Question: What does this figure show? Answer in one sentence.
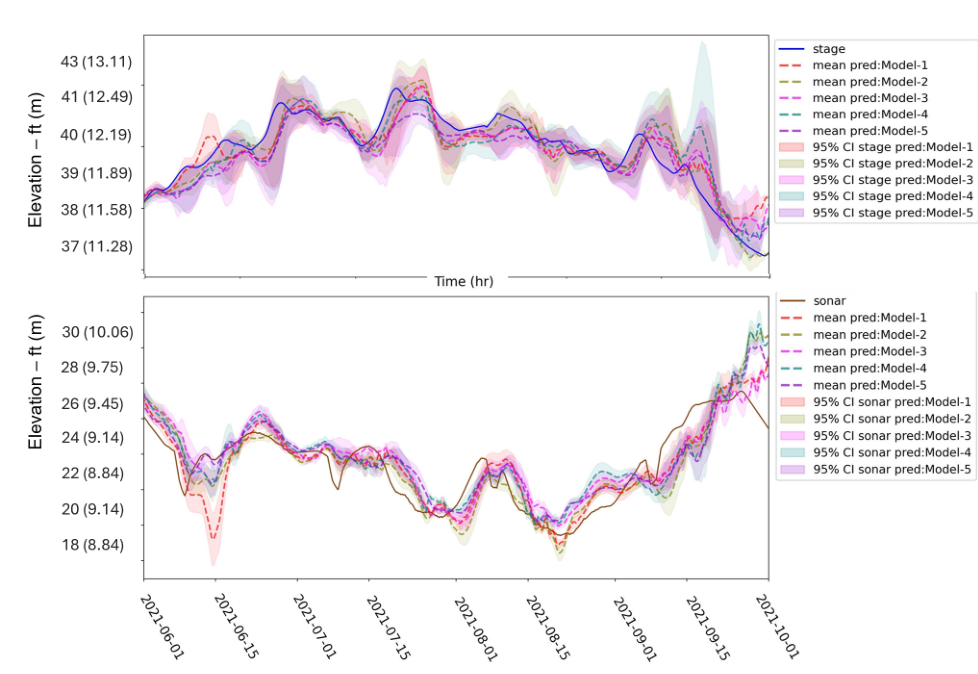
Answer: Stage (top) and Sonar (bottom) predictions of top-5 FCN models selected by the meanMAE policy, mean and 95% confidence intervals over the test dataset - Alaska 539 bridge.